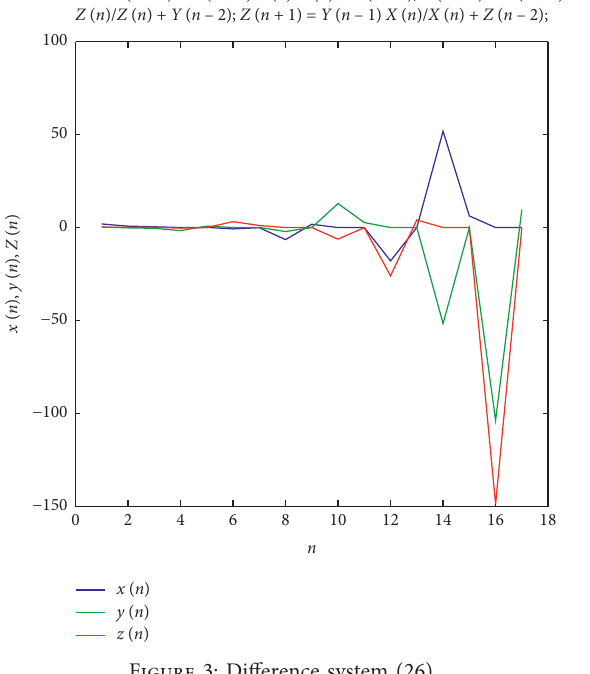
Figure 3: Difference system